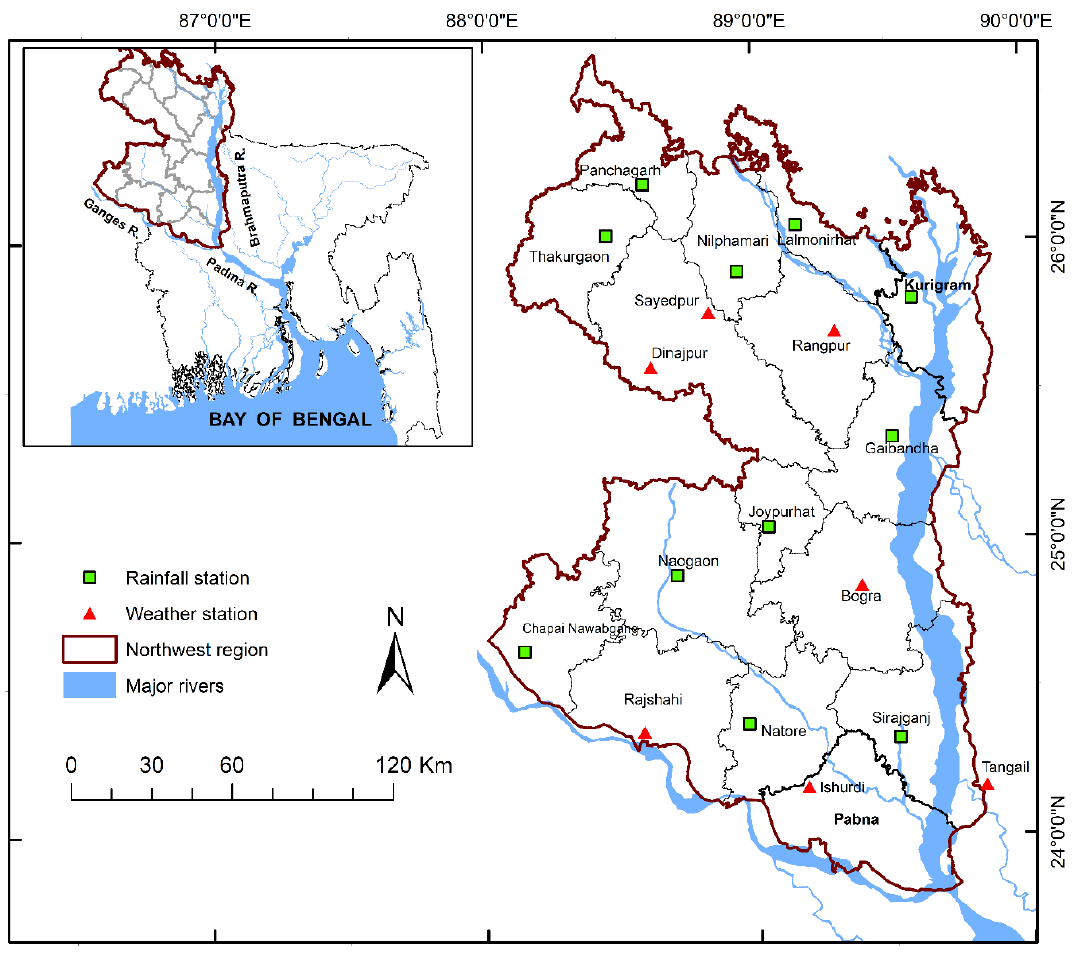
Figure 1. Study area map showing administrative districts and locations of meteorological stations in the northwest region of Bangladesh.